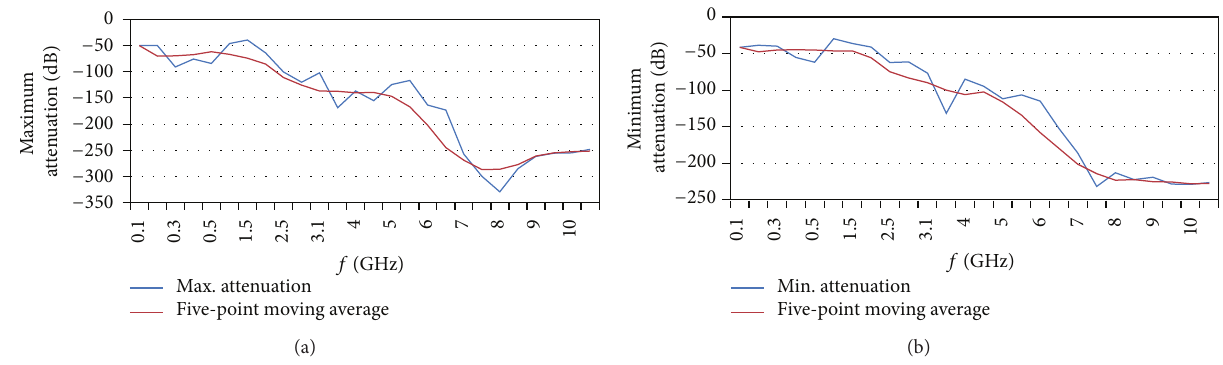
Figure8:Variationsof(a)maximumand(b)minimumsignalattenuationwithfrequency.Superimposedfive-pointmovingaverageisplotted.